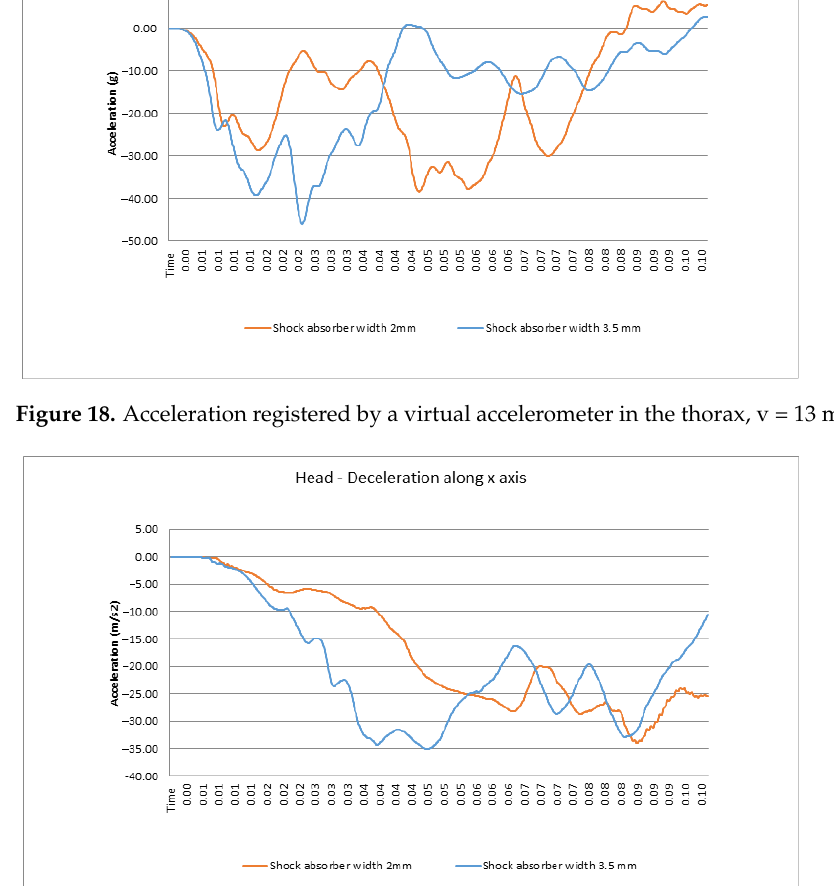
Figure 19. Acceleration registered by a virtual accelerometer in the head, v = 13 m/s. The behavior of the vehicle and its alignment to the acceptance criteria, according to the Formula Student Rules T3.19.1/2022 Version: 0.9, was studied. The model of the car is presented in Figure 20.